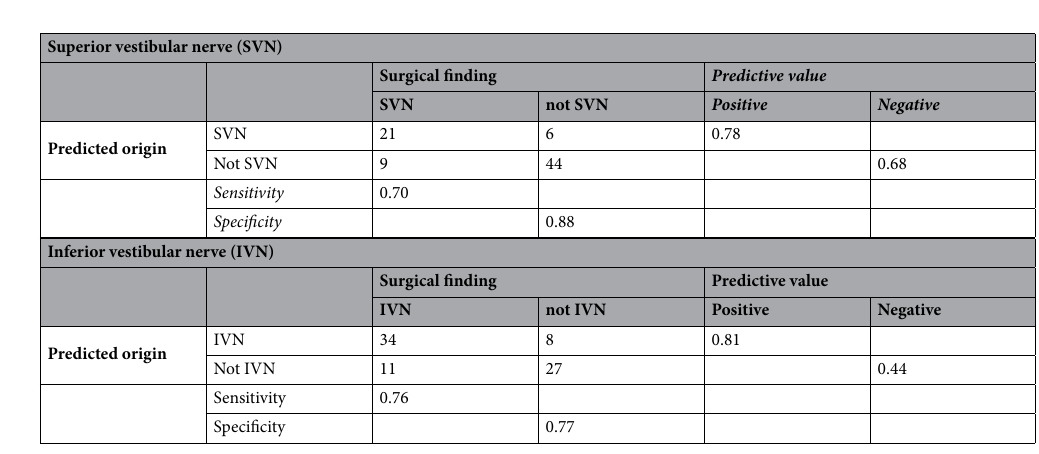
Table 5. Confusion matrix based on optimized decision